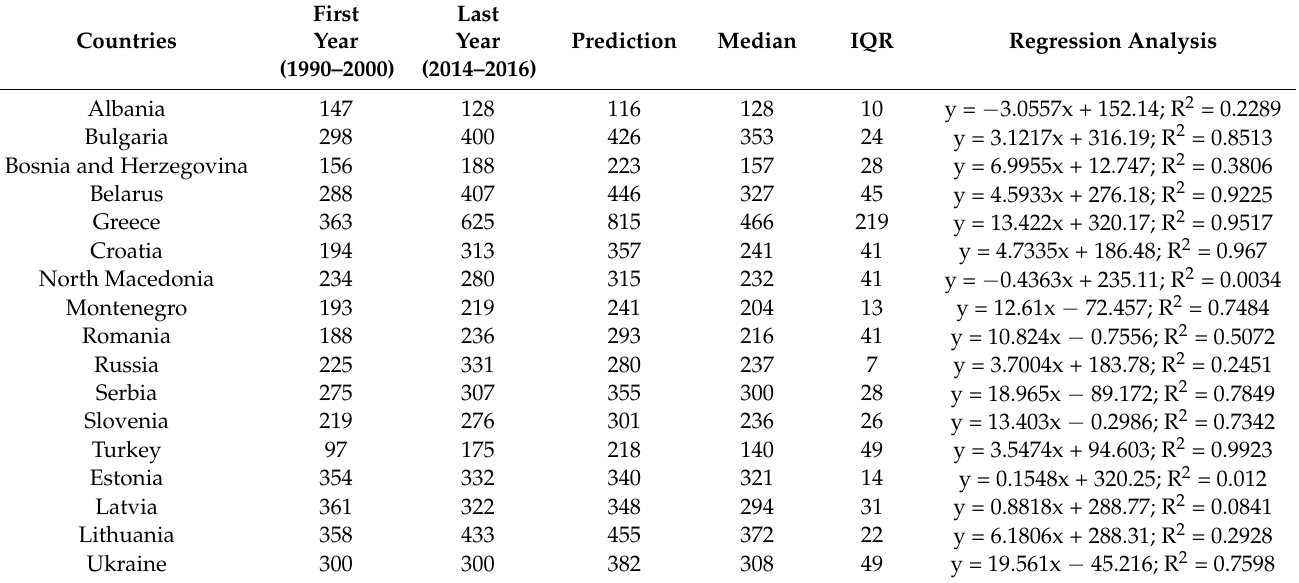
Table 3. Values of the number of healthcare workers per 100,000 inhabitants—value of the first observed year, last observed year, predictive value, median value, inter-incremental difference and linear regression analysis.